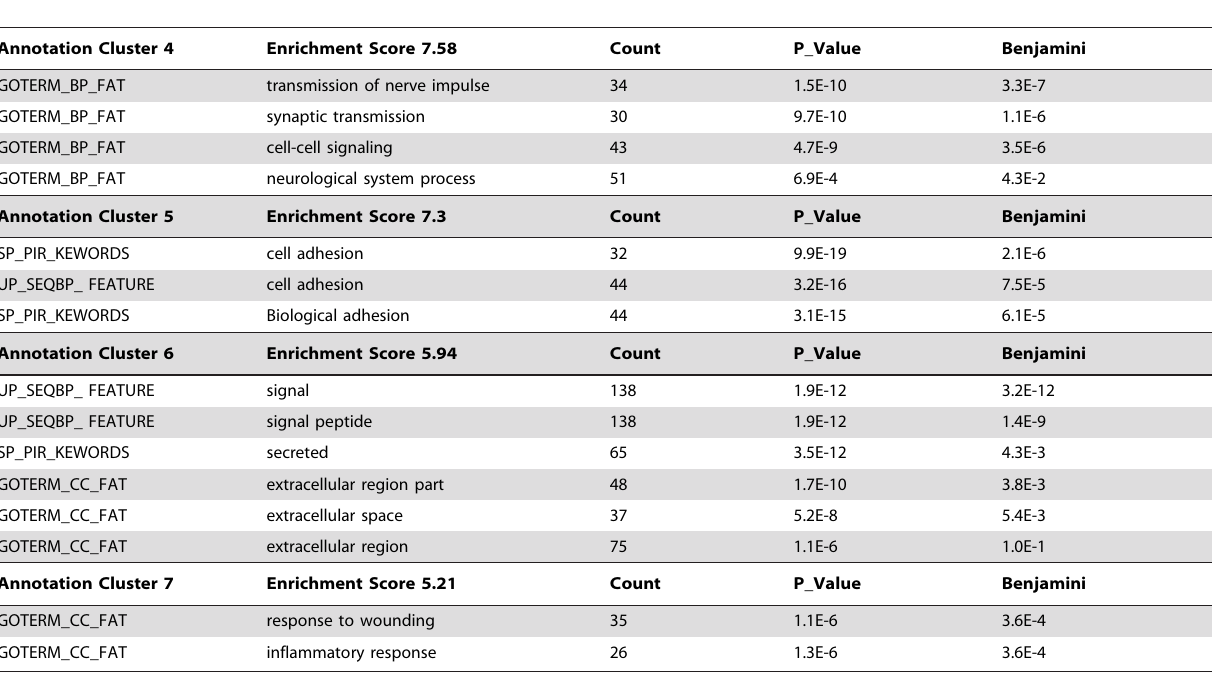
Table 3. Functional Annotation Clustering using DAVID for the top 1200 unregulated genes (Log2 # 5–12) of human substantia